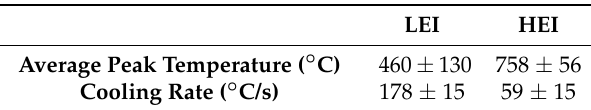
Figure 8. Process temperature evolution of low (LEI) and high (HEI) energy input joints measured by infrared thermography and the comparison with important onset transformation temperatures of the titanium alloy. Table 4. FricRiveting process temperatures and cooling rates for Ti-6Al-4V alloy/GF-P specimens produced under LEI and HEI conditions.